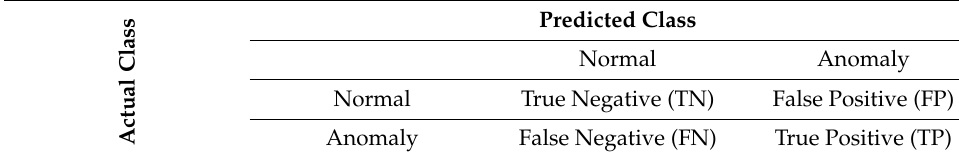
Table 5. Confusion matrix for an anomaly detection